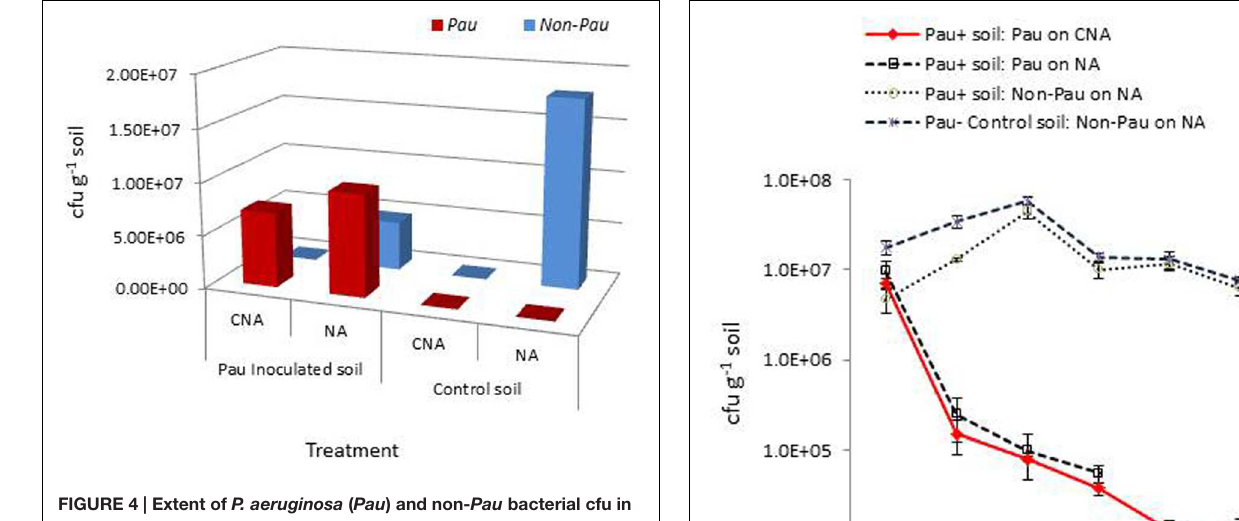
FIGURE 4 | Extent of P. aeruginosa ( Pau ) and non- Pau bacterial cfu in potted rhizospheric soil mix within 30–60 min of Pau application as per the cfu estimations on the selective CNA medium and NA; (cumulative of cfu recorded on day-1 to day-4).